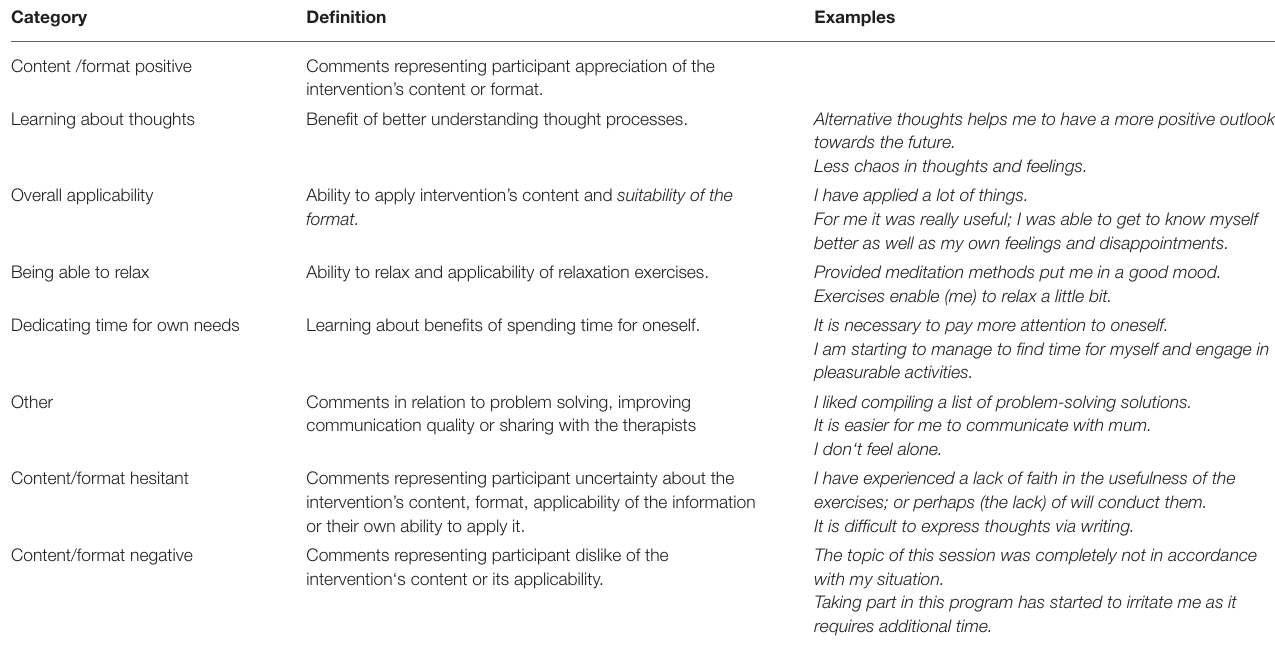
TABLE 4 | Examples of participant comments categorized into Content specific